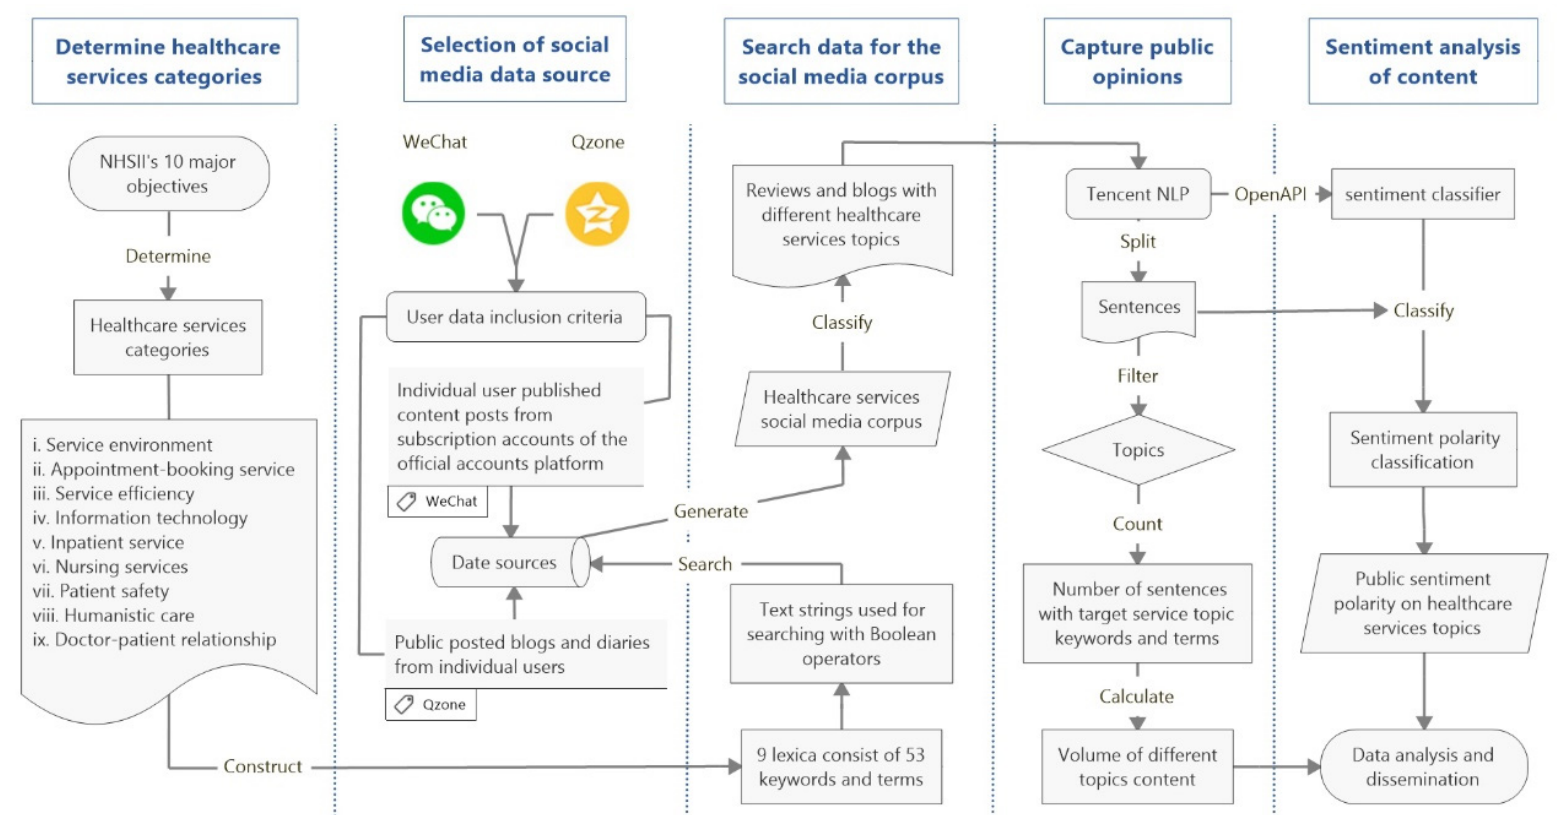
Figure 1. Flowchart of data collection and analysis. Note: NLP, natural language processing; API, application programming interface.